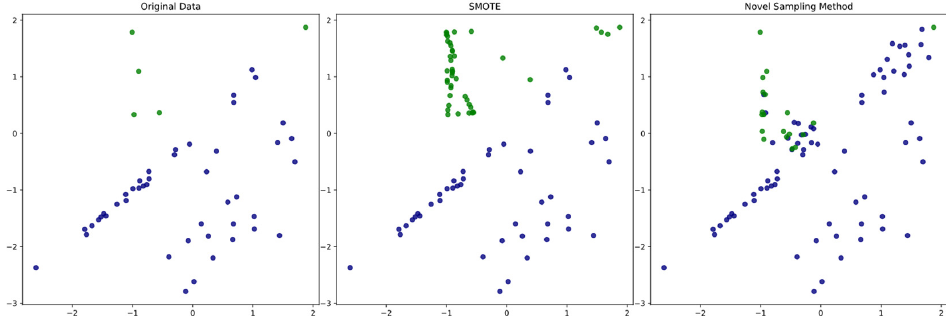
Figure 1. Visualization of resampling based on SMOTE and the fuzzy sampling method. Algorithm 1 Artificial Sample Construction